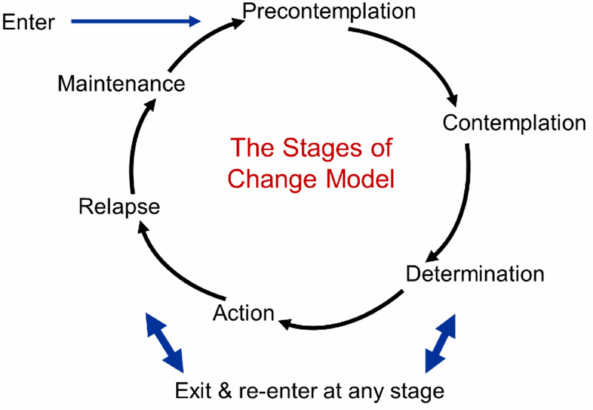
Figure 4. The stages of change model. Reproduced from Prochaska & Di Clemente, The transtheoreti- cal model of health behavior change; published by The American Journal of Health Promotion,